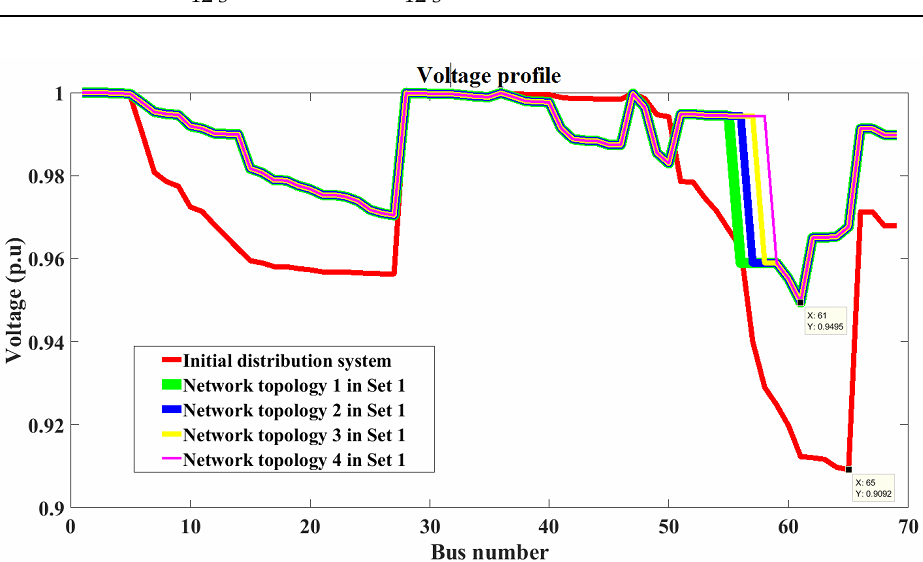
Figure 7. Voltage profiles of optimum network topologies for the 69-bus distribution system in Set 1.